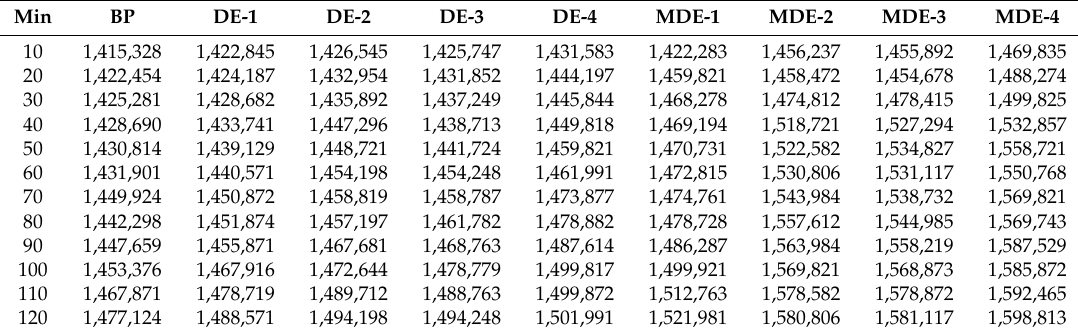
Table 19. Profit of the case study using different controlled simulation times in Thai Baht. Min BP